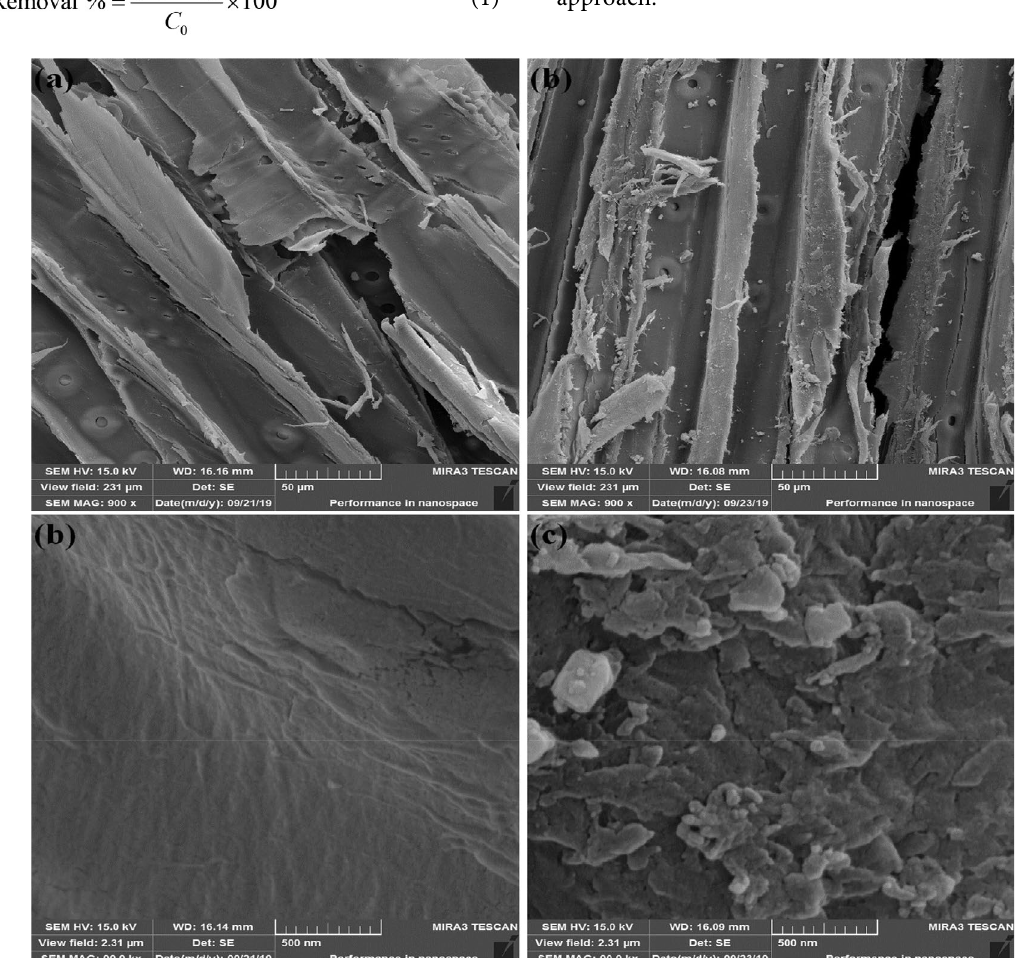
Fig. 1. SEM images of sawdust (a & c) and SD/PAni (b &